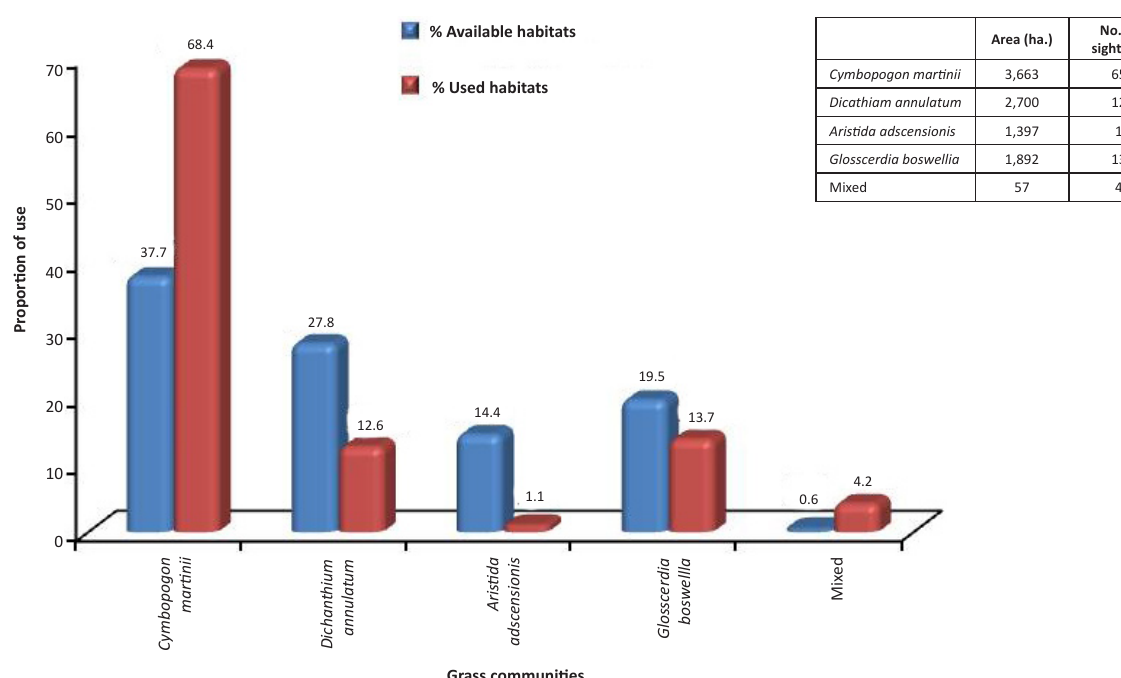
Figure 4. Proportional availability and use of various grass communities in the distribution range of GIB in Gujarat